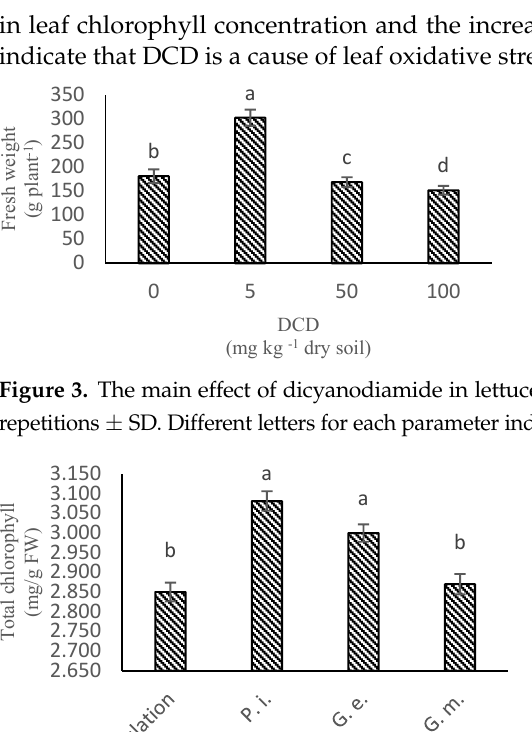
Figure 2. The mean effect of P. indica , G. etunicatum , and G. mosseae in lettuce plant fresh weight. (The means refer to four repetitions ± SD. Different letters for each parameter indicate significant differences assessed ( p < 0.05).)